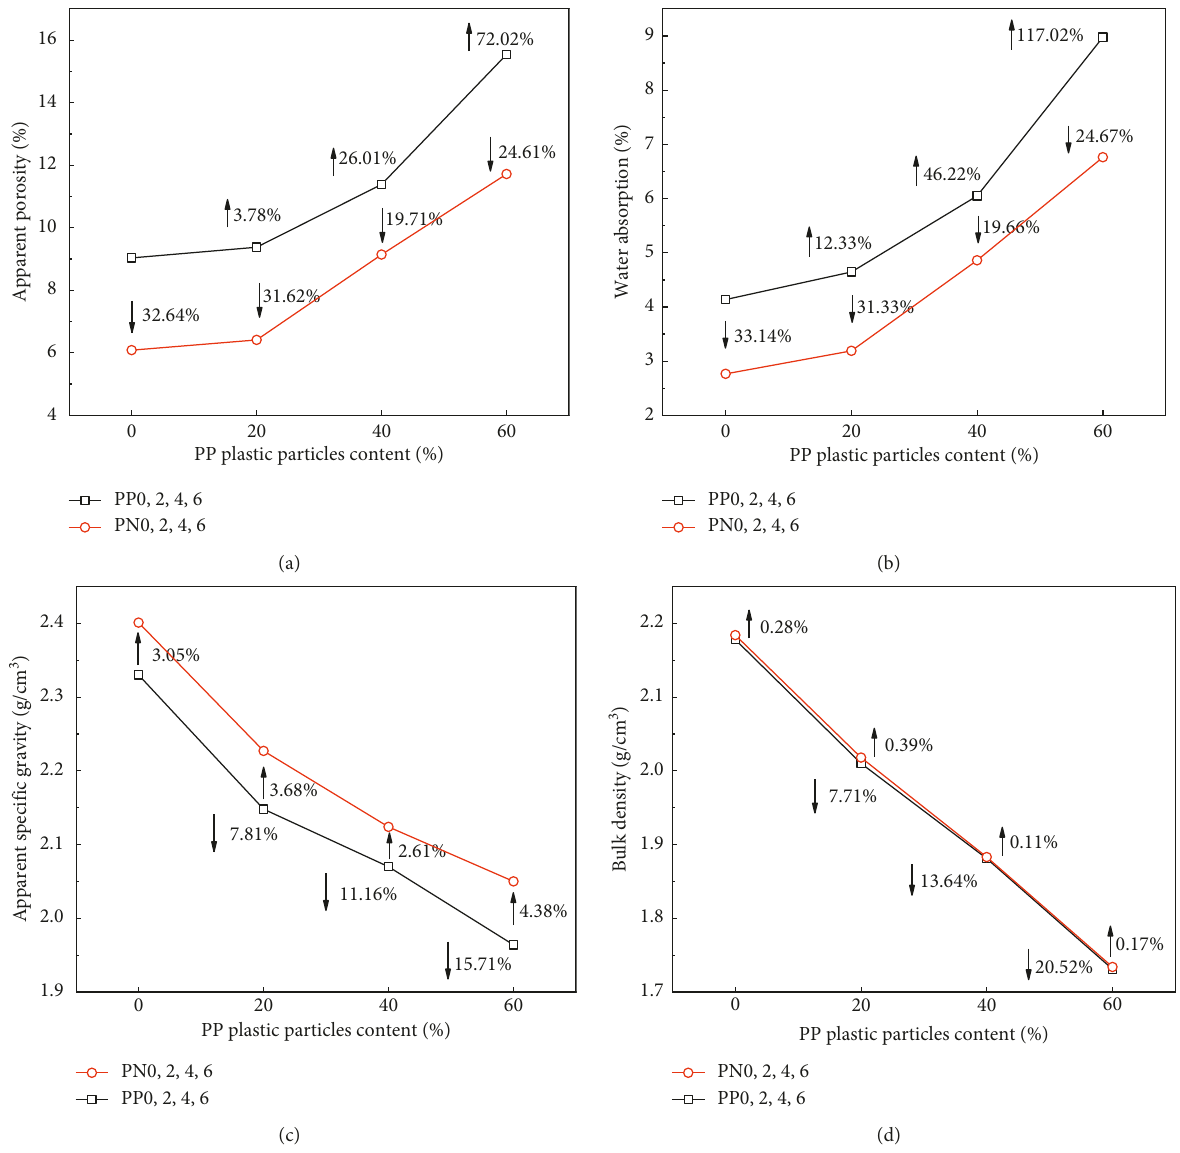
Figure 3: Effect of the recycled PP plastic particles content on physical properties of the PP-filled mortar: (a) apparent porosity, (b) water absorption, (c) apparent specific gravity, and (d) bulk